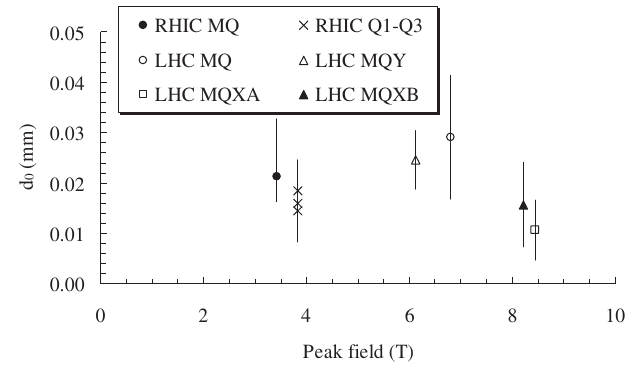
(cid:5) 0 : 011 mm 0 FIG. 3. Coil positioning versus peak field derived from mag- netic measurements of 6 types of superconducting quadrupoles.